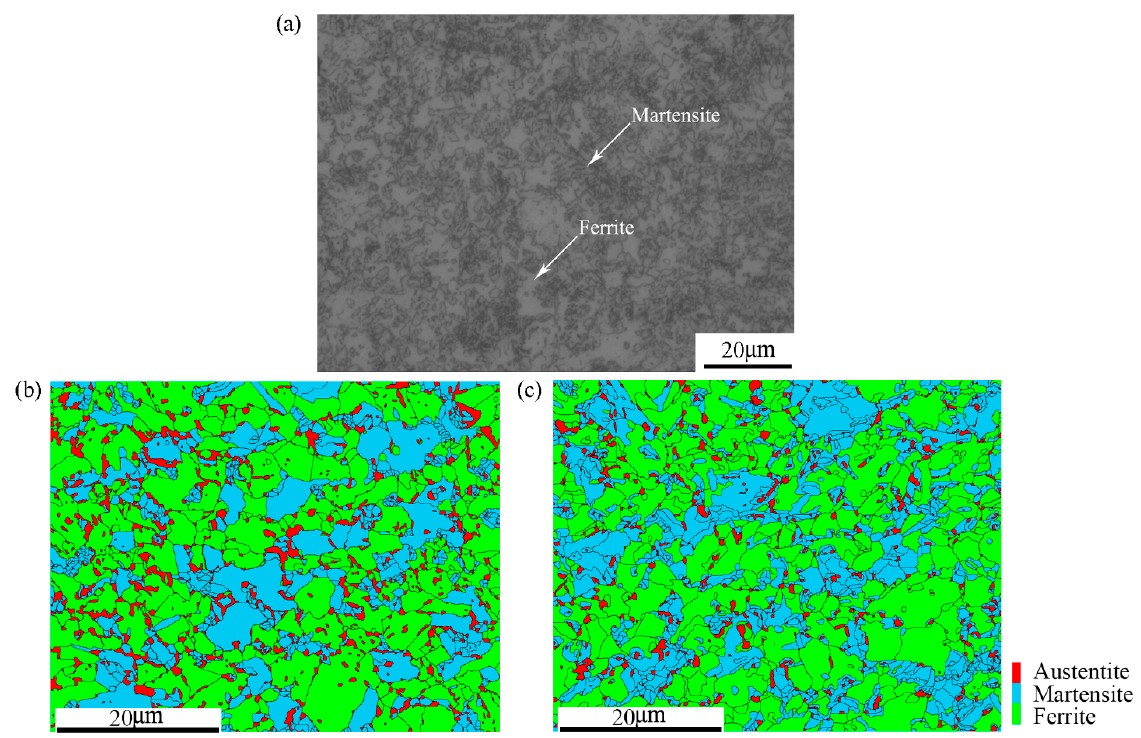
Figure 1. Microstructure of QP980 steel sheet: ( a ) martensite and ferrite are characterized by OM (1000 × ); ( b ) EBSD characterization of QP980 steel when ε eq = 0; ( c ) EBSD characterization of QP980 steel when ε eq = 0.11. Table 2. Fractions of phase volume (%) of the QP980 steels ( ε eq = 0 and ε eq = 0.11 ). Phase Volume Fraction V